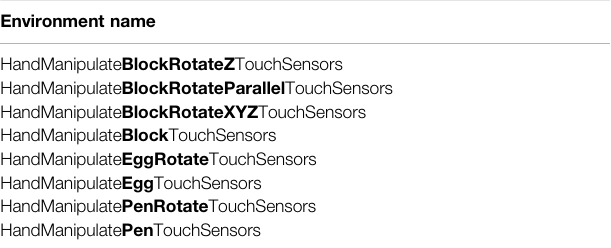
TABLE 3 | New OpenAI Gym Robotics Environments with 92 Touch Sensors: – v0 (Boolean), – v1 (Continuous-Value). Environment